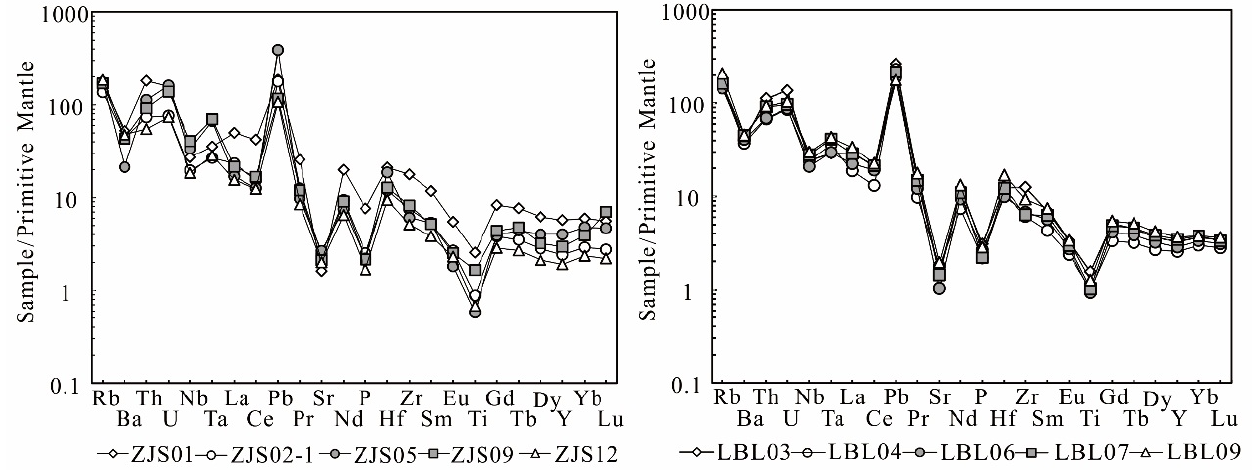
Figure 2. Primitive mantle-normalized trace element patterns of stream sediments in the Zijinshan Copper-Gold Orefield. Primitive Mantle normalized data are from [42].